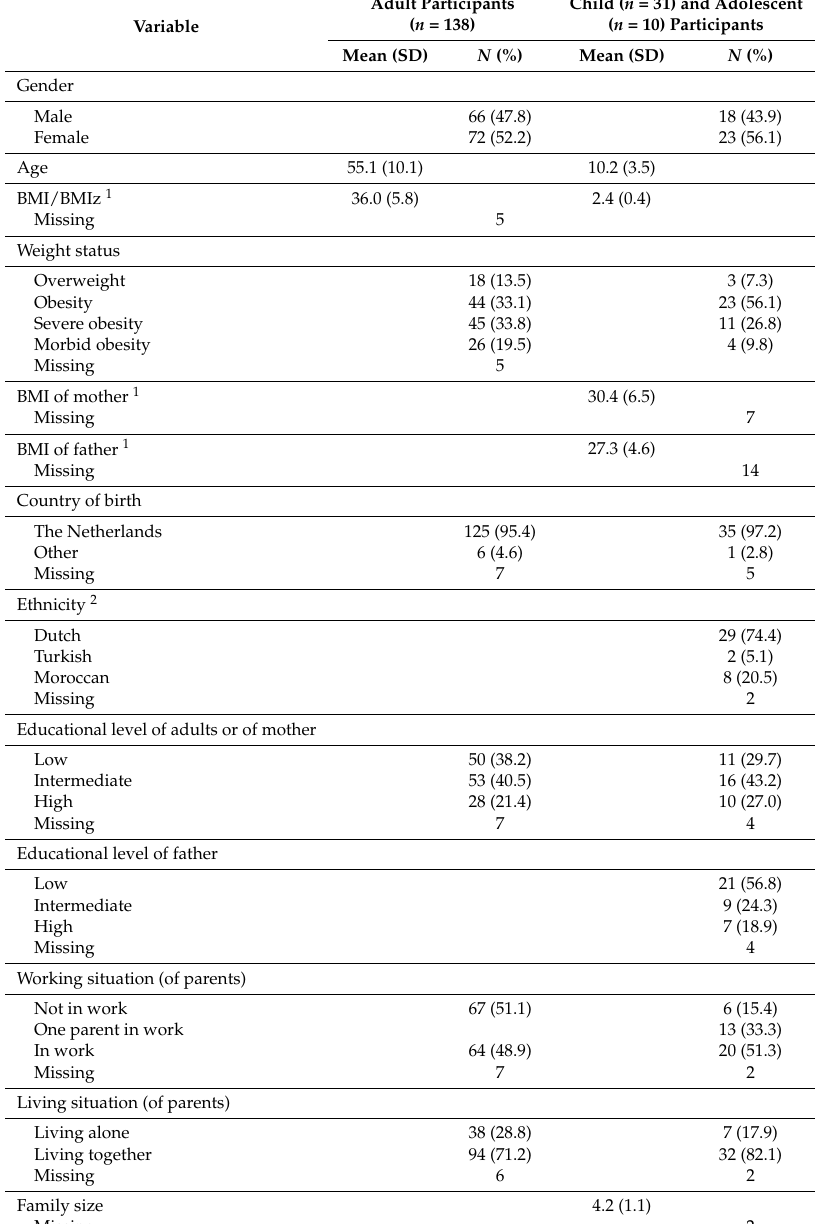
Table 1. Demographics and weight-related characteristics of the